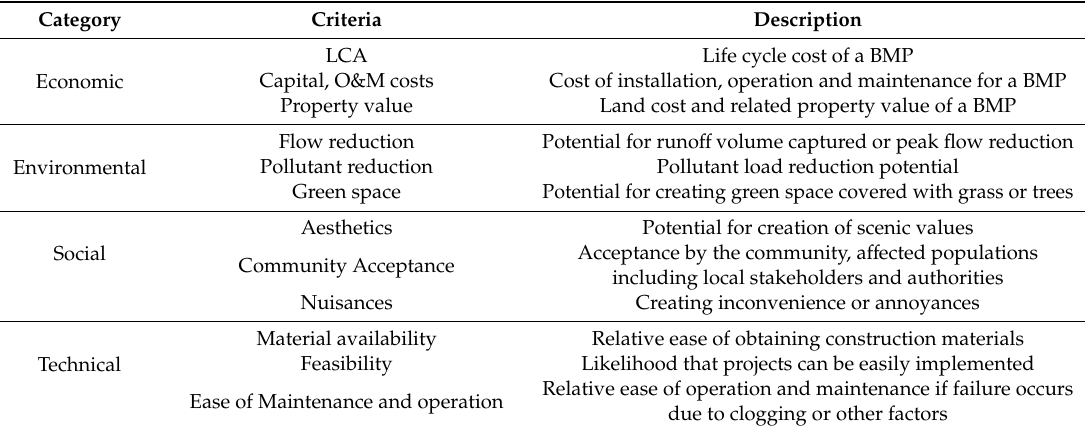
Table 2. BMP selection sustainability criteria (user weighting